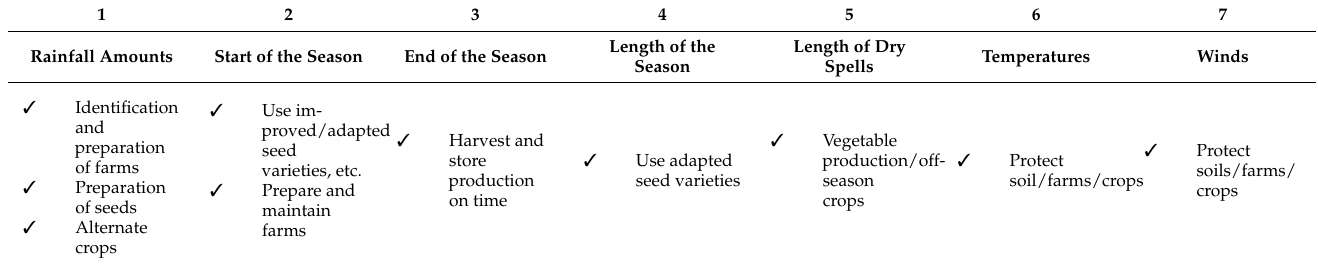
Table 4. Strategies to be implemented for good agropastoral season perspectives.